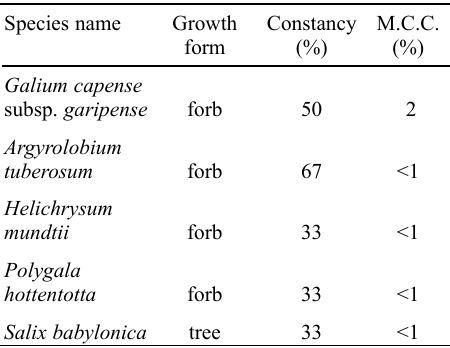
Table 7 Diagnostic species of the Rhus gerrardii- Hemarthria altissima grassland (M.C.C. - mean canopy